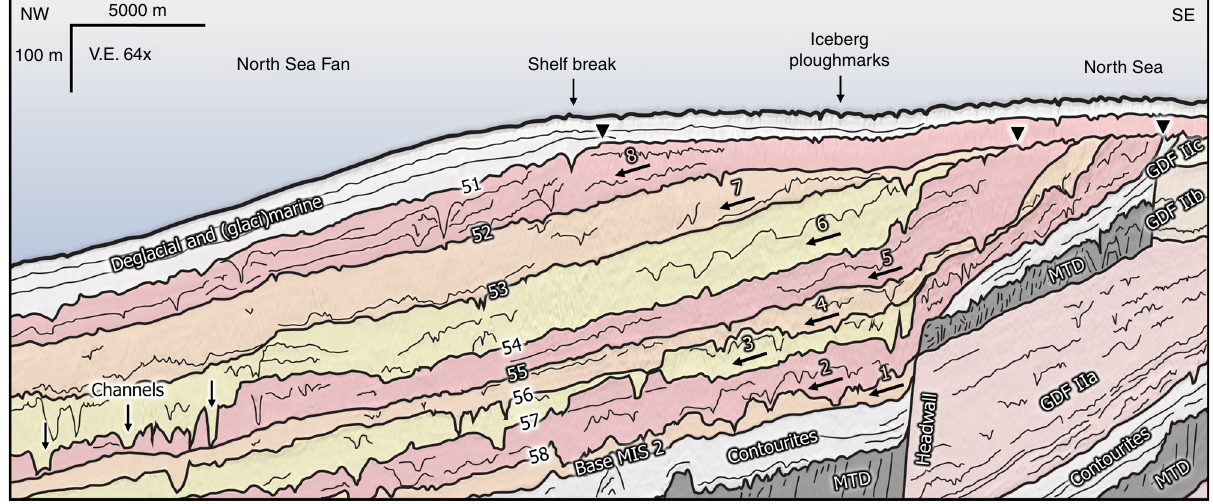
Fig. 3 Seismic stratigraphy of the deposits related to the last glaciation (Weichselian, MIS 2) of the North Sea Fan. Eight glacial sub-units are colored in yellow to red, and are indicated by arrows. The top re fl ections of the sub-units can have a negative-amplitude re fl ection (54, 56 – 58), or a positive amplitude re fl ection (52, 53, and 55). Deep, V-shaped depressions are recognized both at the top of the sub-units and along re fl ections within the sub- units. Contourites (light grey), Tampen Slide MTD (dark grey), GDFs related to the Saalian glaciation (MIS 6, light yellow to light red), and paleo-shelf break positions (black triangles) are shown. MIS marine isotope stage, MTD mass transport deposit. Pro fi le located in Fig. 2a. V.E. vertical exaggeration. For uninterpreted seismic pro fi le see Supplementary Fig.